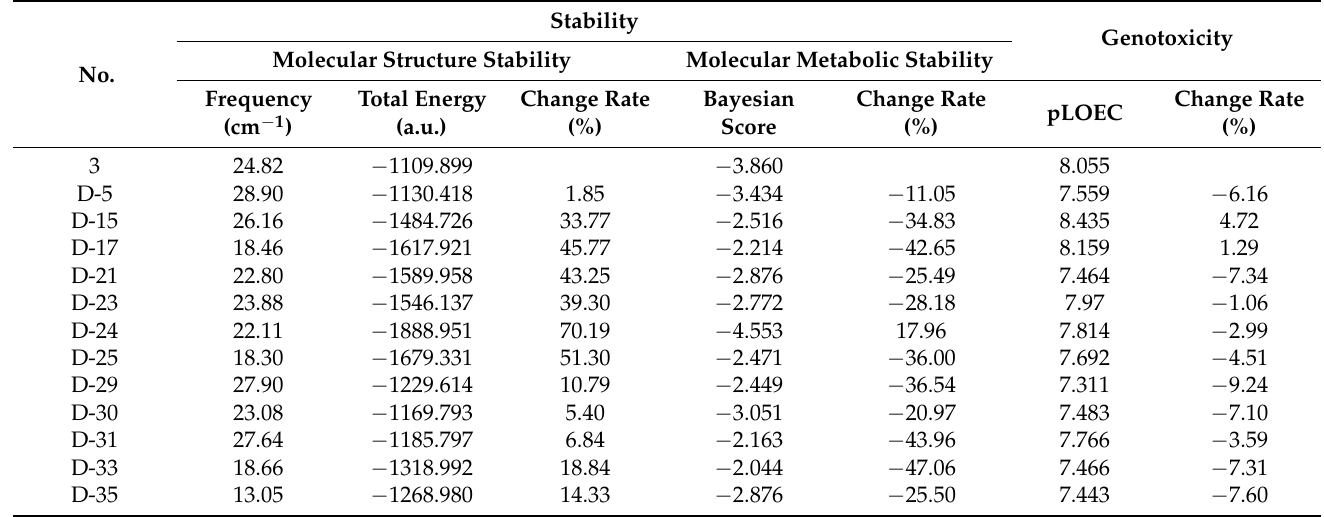
Table 6. Functional evaluation parameters of molecular stability and genotoxicity for NOR and its derivatives.